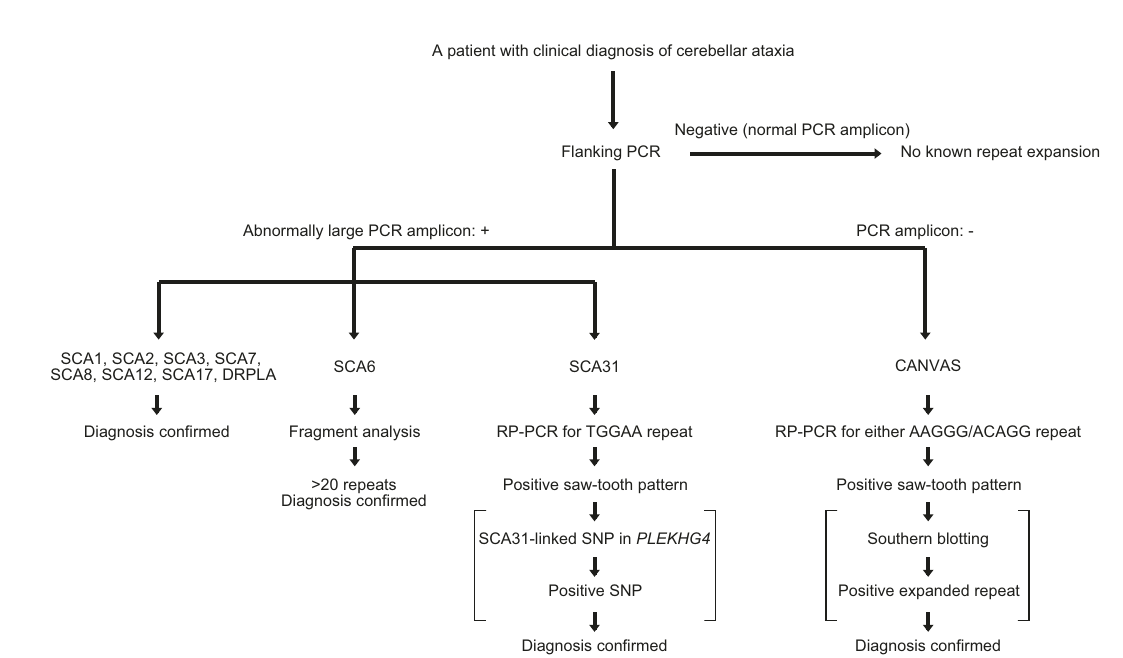
Fig. 5 Our conventional screening work fl ow for known repeat expansion diseases manifesting cerebellar ataxia. Square brackets indicate procedures that can be omitted for diagnosis. From this screening work fl ow, we excluded SCA10, SCA37, and Friedreich ataxia because of their rarity, and SCA36 because of their regional distribution in Japan. DRPLA dentatorubral-pallidoluysian atrophy, CANVAS cerebellar ataxia, neuropathy, vestibular are fl exia